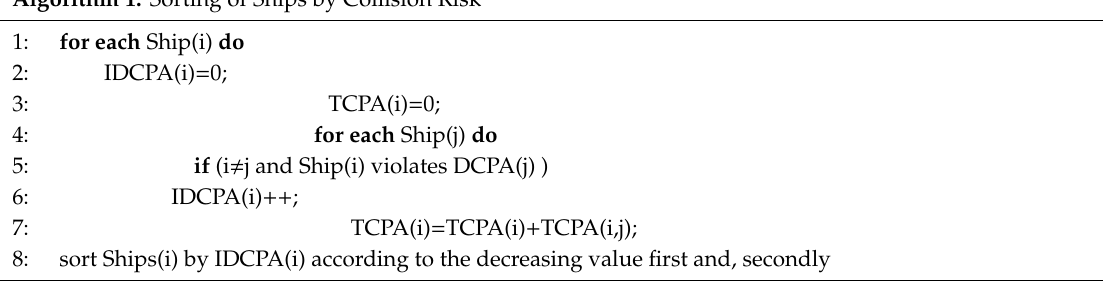
Algorithm 1: Sorting of Ships by Collision